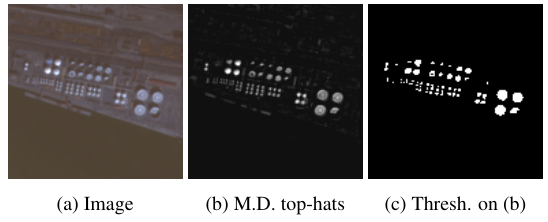
Figure 6. Thresholding on minimum of directional top-hats.